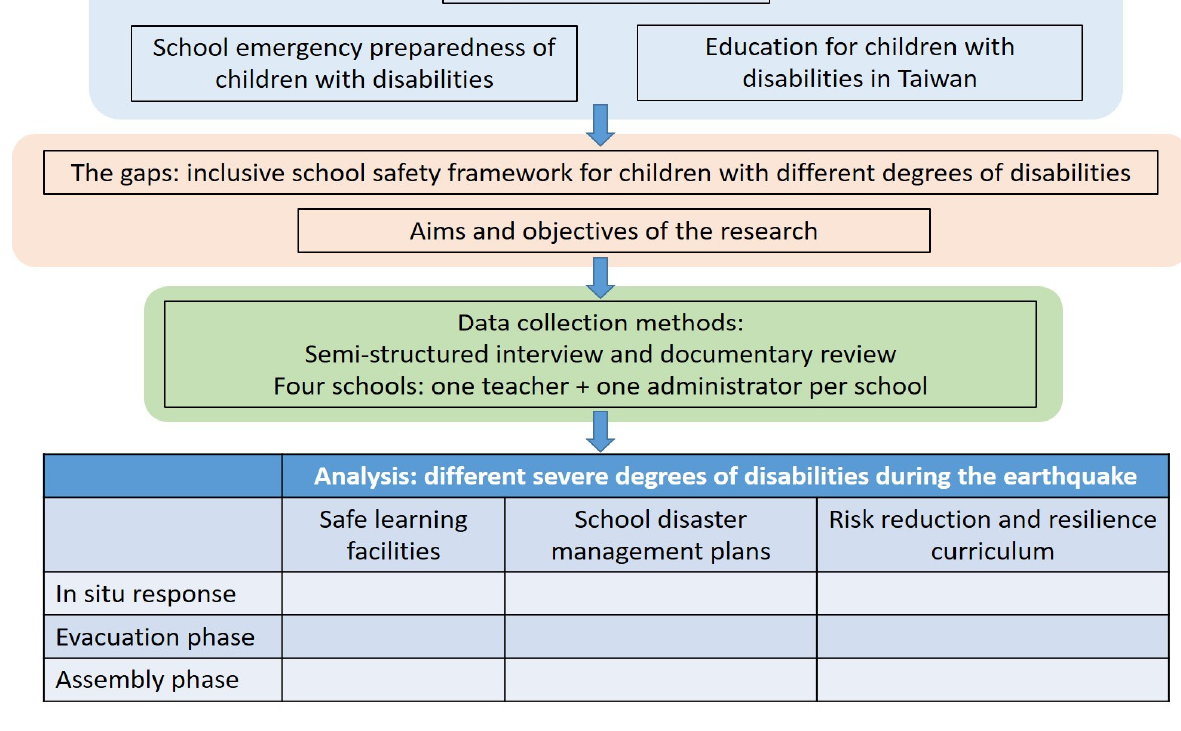
Figure 1. Process of research and framework of analysis.